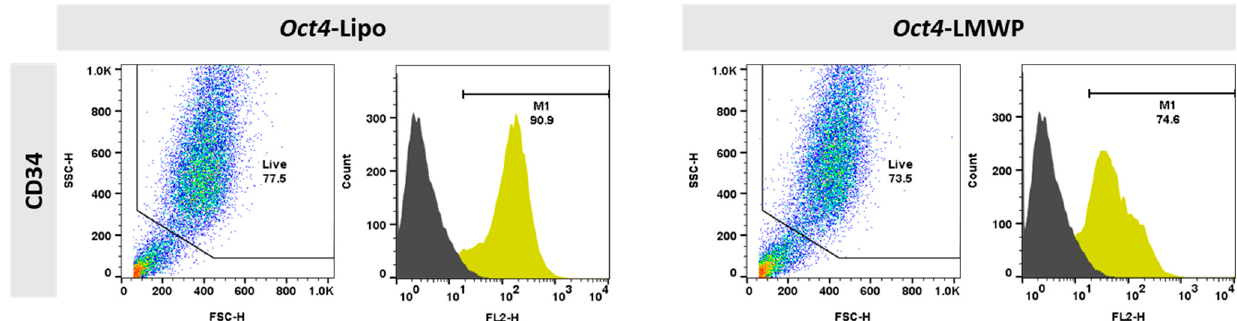
Figure 5. Surface marker expression in Oct4 -treated MEF cells was characterized and compared using FACS analysis. Oct4 was delivered by either lipofectamine ( Oct4 -lipo) or in complex with LMWP ( Oct4 -LMWP ) . CD34 fibroblast-specific cell surface marker was examined in each delivery system. Negative control peak is indicated as dark gray color, CD34 are indicated as yellow peaks, respectively.